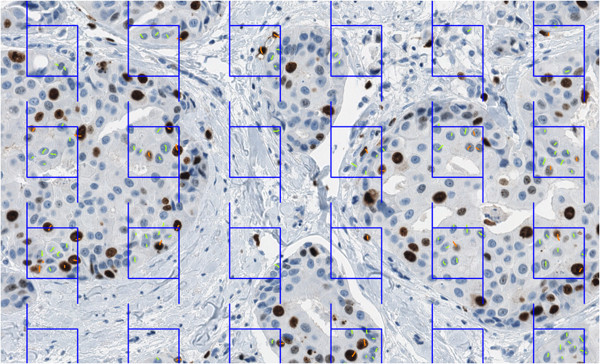
Test grid of frames from the stereology module overlaid on the TMA spot image. The left and bottom lines of a frame are “forbidden” - nuclear profiles intersecting them are not marked. The short line marks (orange for Ki67-positive, green for Ki67-negative tumour cell nuclear profiles) are produced manually by an observer. Total numbers and Ki67 LI are computed by the software at the end of the procedure. TMA, tissue microarray.